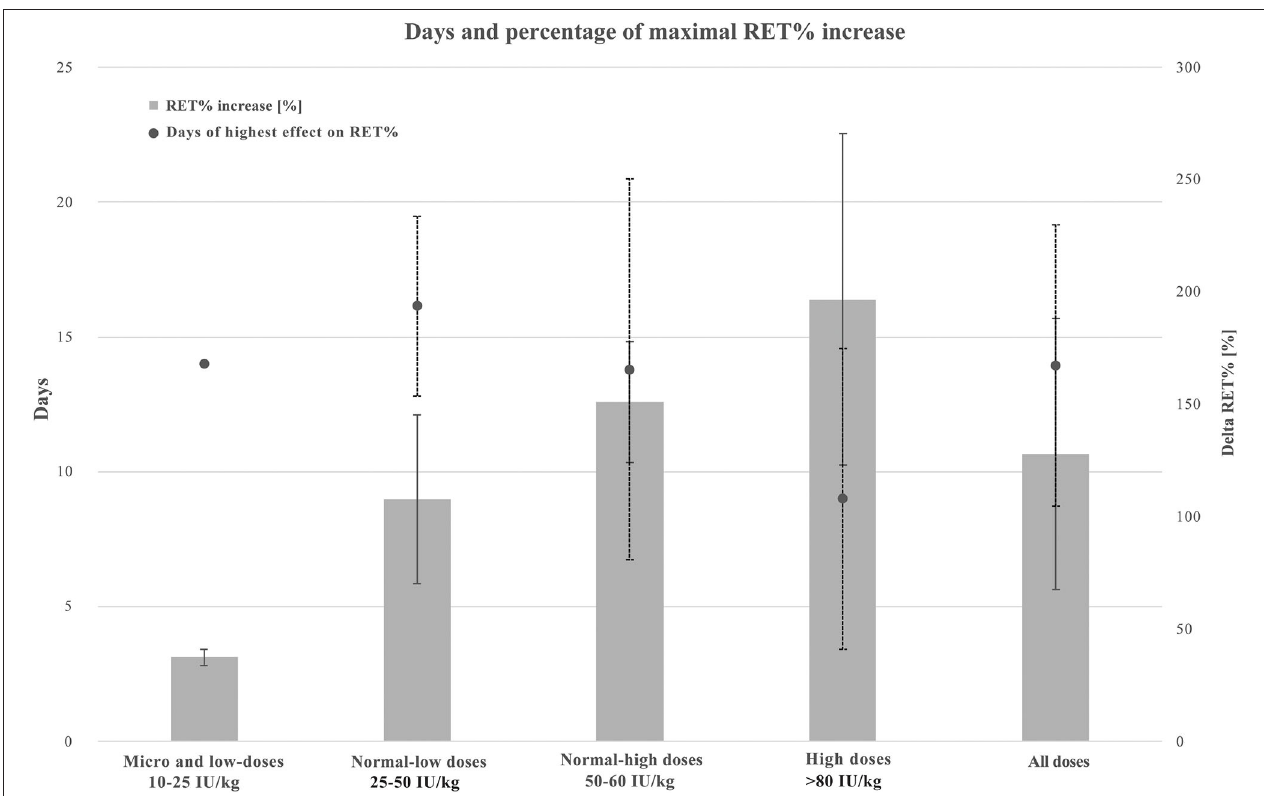
FIGURE 4 | Combined graphic illustrating maximal RET% increase and average days of highest RET% increase when using micro and low (10–25 IU/kg, n normal-low (25–50 IU 7kg, n 7), normal-high (50–80 IU/kg, n 5), high (250–450 IU/kg, n 3), and all the doses of rhEPO. Values are presented in average and = = = standard deviation (SD). A solid line for RET% increase SD and a dotted line for days of highest effect on RET% SD. RET%, reticulocyte ± ±